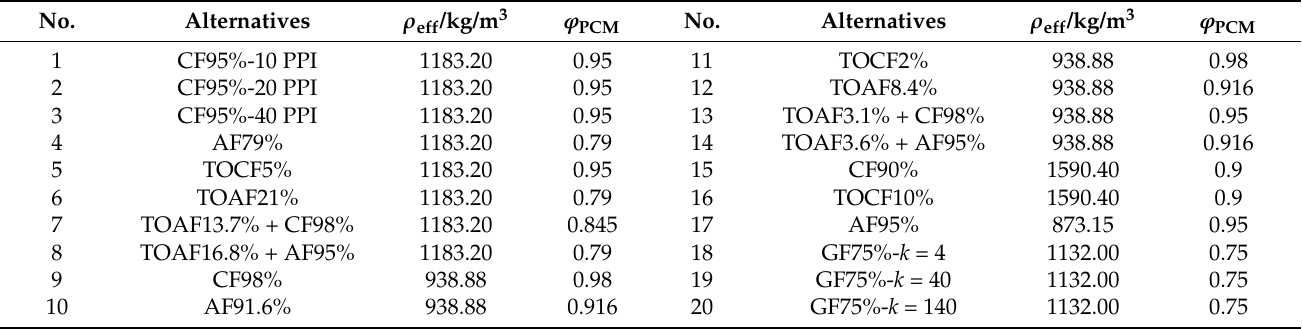
Table 3. Information of